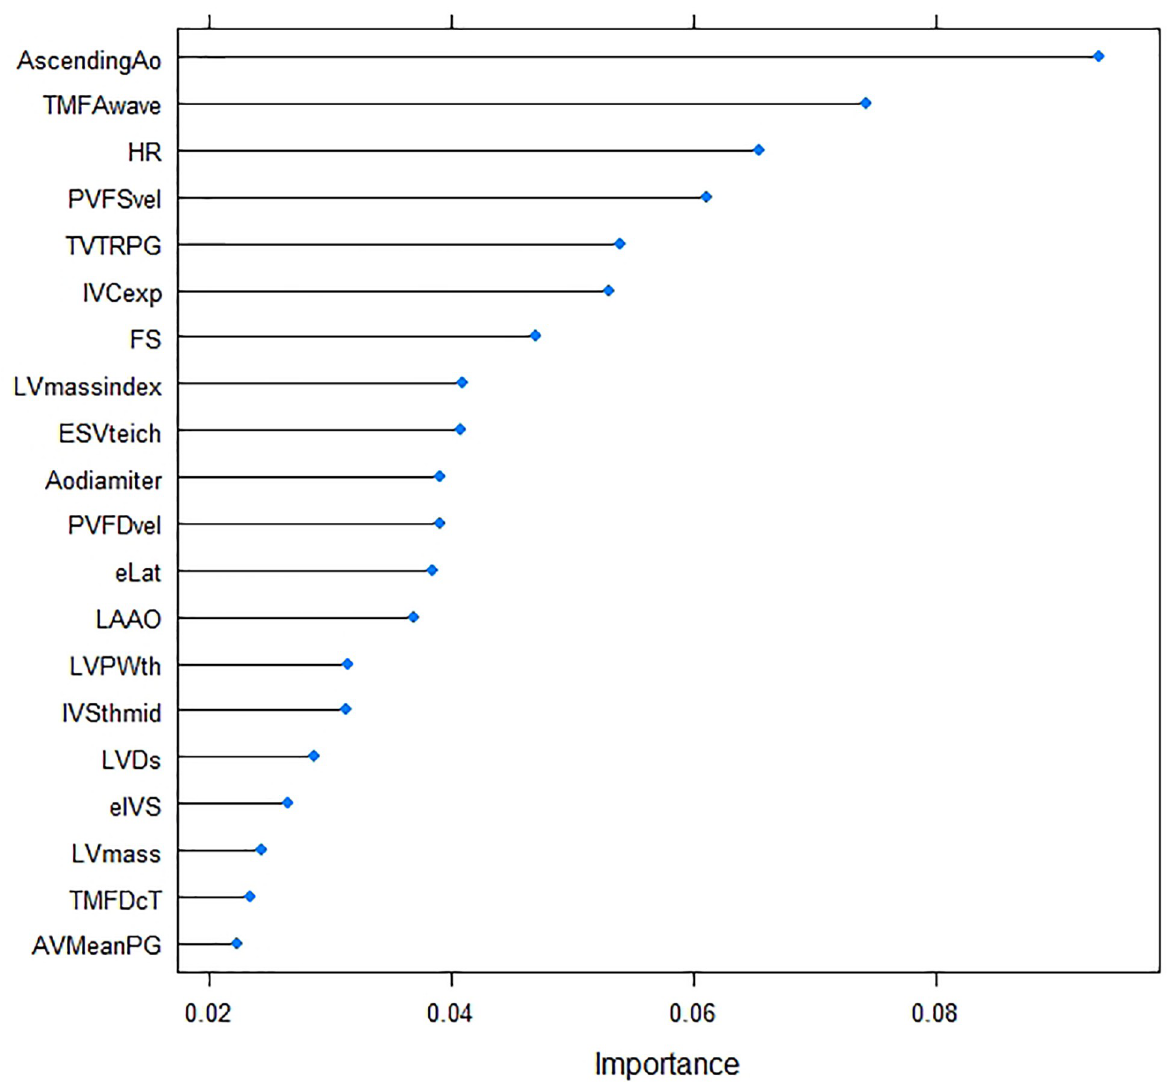
Fig 5. Variable importance of features included in the gradient boosting machine learning (XGB) algorithm for predicting postinduction hypotension. Variable importance is computed according to the degree of importance of any given feature to aid during classification when the classifier is built, determined by its effect on the performance measure. The greater the importance, the more essential the variable is to the performance of the model. Ao; aorta, TMF; trans mitral flow, HR; heart rate, PVF; pulmonary venous flow, TVTRPG; tricuspid regurgitation pressure gradient, IVC; inferior vena cava, FS; fractional shortening, LV; left ventricular, ESV; end-systolic volume, LA; left atrium, LVPWth; thickness of the left ventricular posterior wall, IVS; interventricular septum, LVDd; left ventricular diameter at the end diastole, AV; aortic valve, PG; pressure